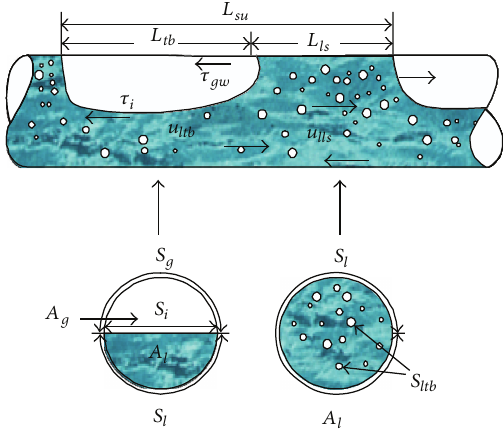
Figure 21: A schematic of key geometrical parameters in horizontal slug